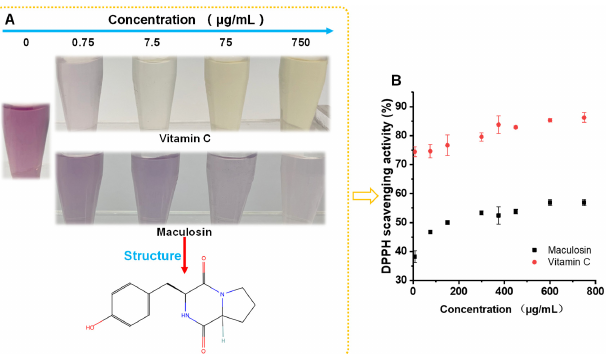
Figure 7. Confirmation of DPPH scavenging activity of maculosin by visual observation ( A ) and quantification ( B ). Vitamin C is a positive